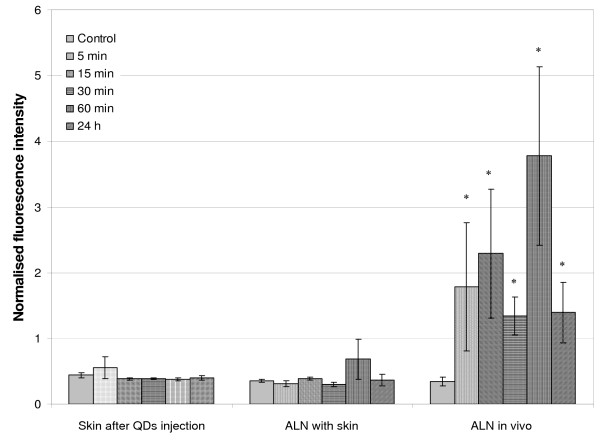
Normalised 655 nm fluorescence intensity detected by LIF with optical fiber spectrofluorometer. 20 pmol of QDs or PBS (control mice) were injected subcutaneously in the distal part of the anterior paw of a nude mice. Kinetics of LIF measurements were done on skin after QDs injection, ALN with skin and in vivo for control, 5 min, 15 min, 30 min, 60 min and 24 h. Error bars represent SEM, values marked with asterisk were significantly different from control (* for P < 0.05). QDs: Quantum Dots; LIF: Laser-Induced Fluorescence; ALN: Axillary Lymph Node.